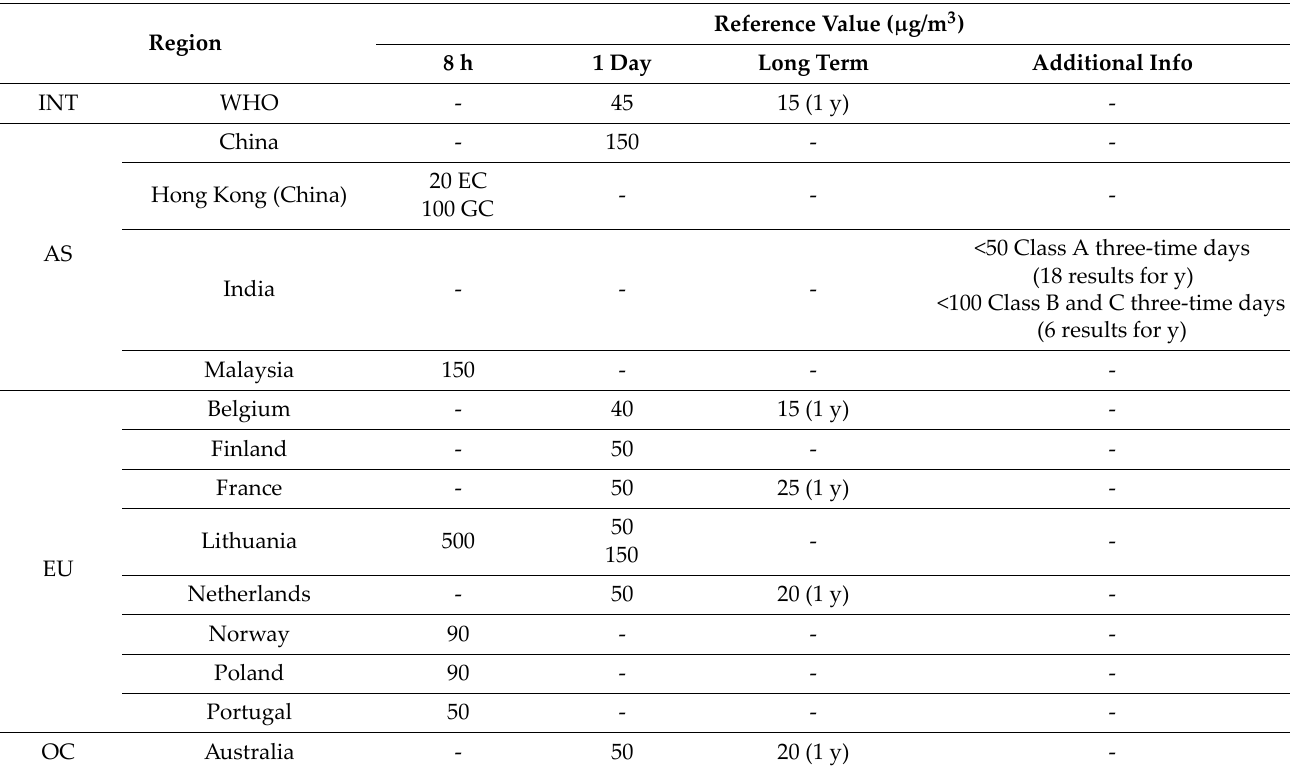
Table 14. Reference values for PM 10